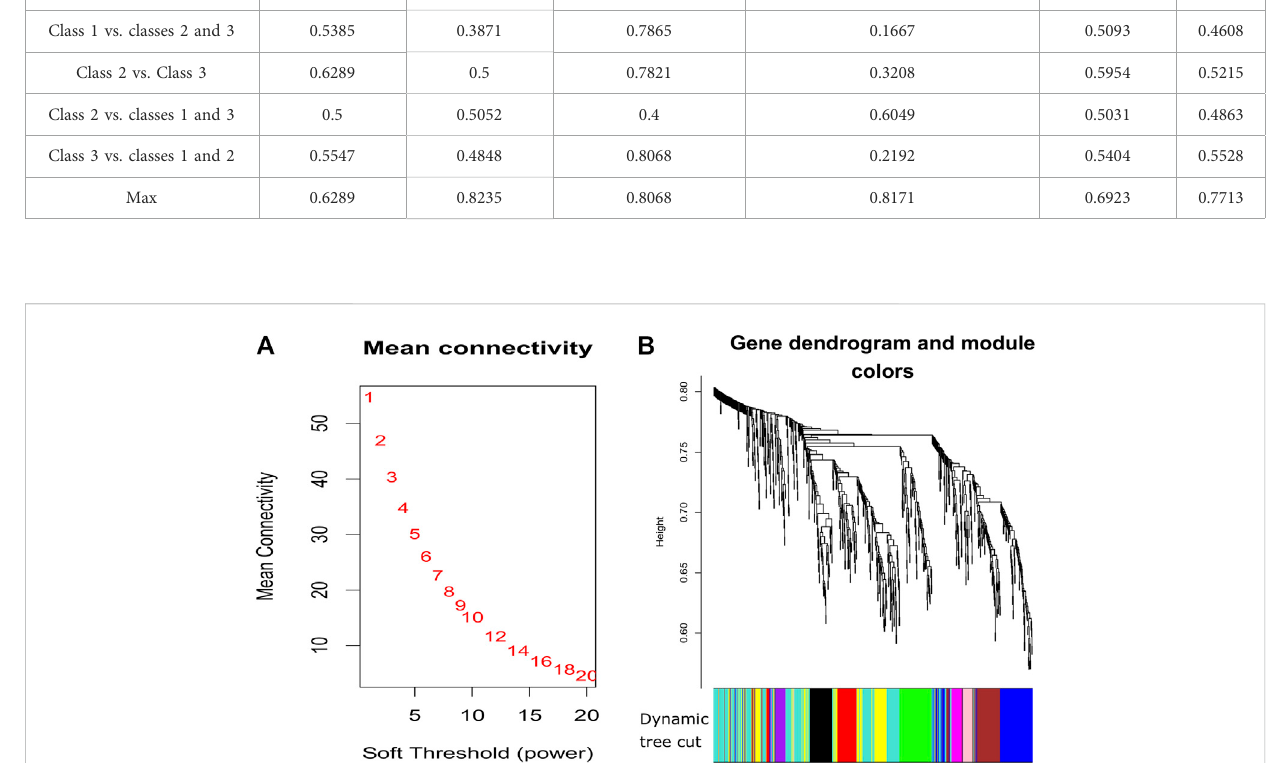
FIGURE 3 Plots for soft thresholding and dendrogram for our proposed method. (A) Power computing for soft thresholding and (B) dendrogram plots with dynamic tree